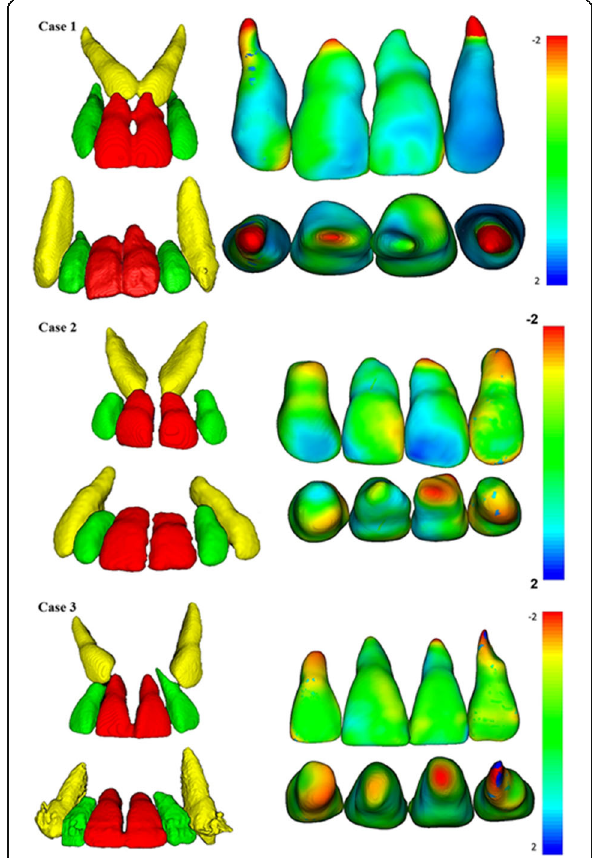
Fig. 9 3D superimposition of maxillary incisors: upper figure — case 1 (before and after traction), middle figure — case 2 (before and after traction), and lower figure — Case 3 (before and after